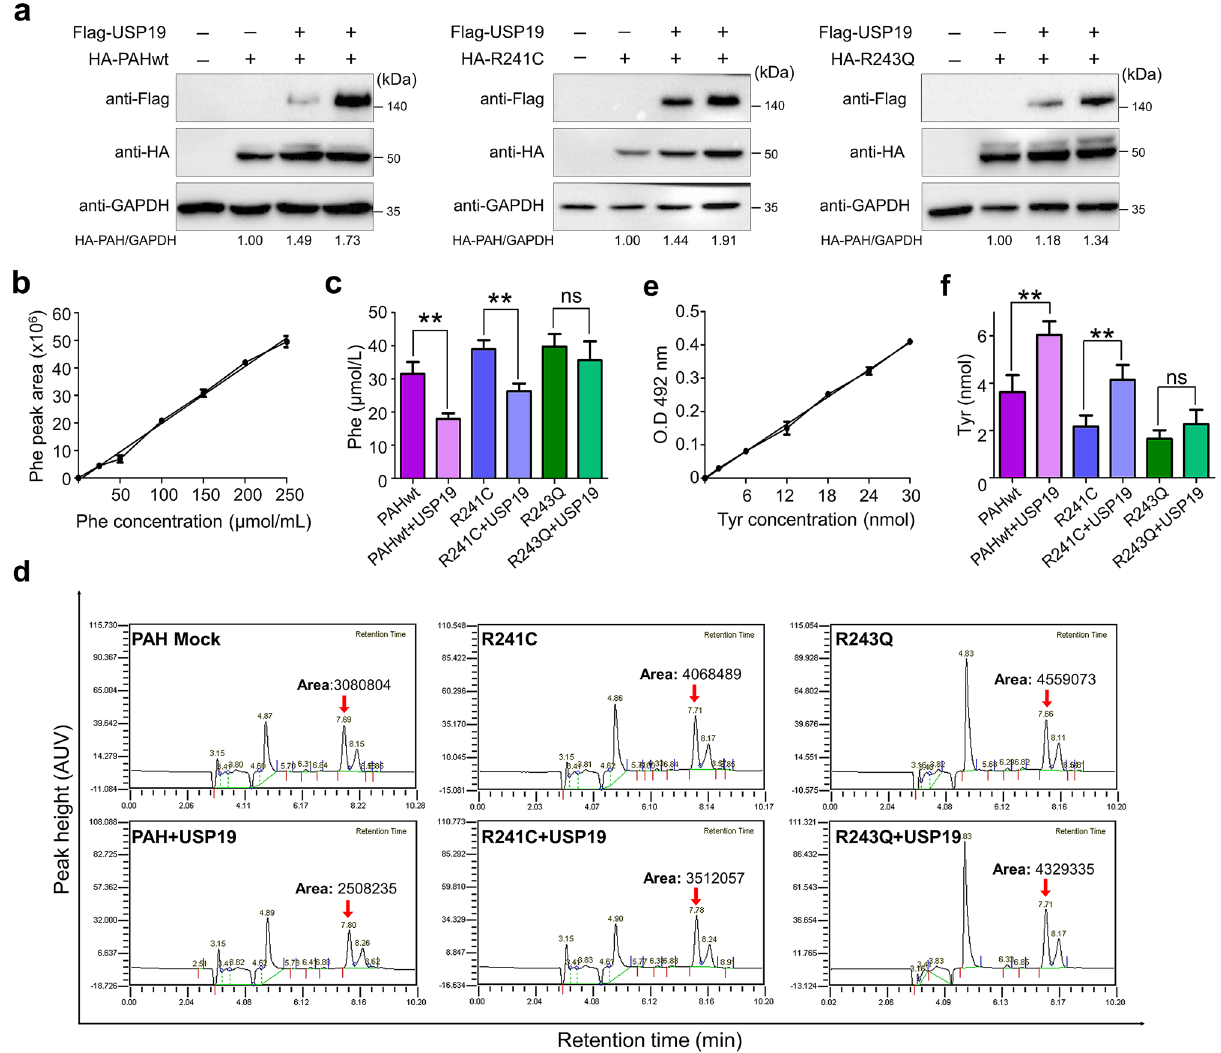
Figure 6. USP19 extends the residual enzymatic activities of R241C and R243Q. ( a ) Western blot analysis shows the transfection efficiency of the respective constructs used for further experiments. ( b ) A standard curve of Phe obtained from HPLC, representing an increasing concentration of Phe in µmol/mL, was plotted against the Phe peak area. ( c ) The residual activity was analyzed by HPLC by quantifying the amount of Phe metabolized by cells expressing R241C and R243Q in the presence of USP19. Data are presented as the mean ± SD of three independent experiments. One-way ANOVA followed by Tukey’s multiple comparisons test was used (** P < 0.005; ns denotes non-significant). ( d ) The HPLC chromatogram of a PAH activity assay shows a Phe peak at a retention time of ~ 7.7 min. The Phe peak is indicated by a red arrow, and the measurement of the peak area is denoted at the top of the peak. ( e ) Standard curve of Tyr, representing an increasing concentration of Tyr in nmol, was plotted against the absorbance at OD 492 nm. ( f ) A tyrosine assay kit was used to analyze the residual activity of R241C and R243Q in the presence of USP19. Specific PAH activity is expressed as the amount of Tyr (nmol) produced by each sample. Data are presented as the mean ± SD of three independent experiments (** P < 0.005; ns,